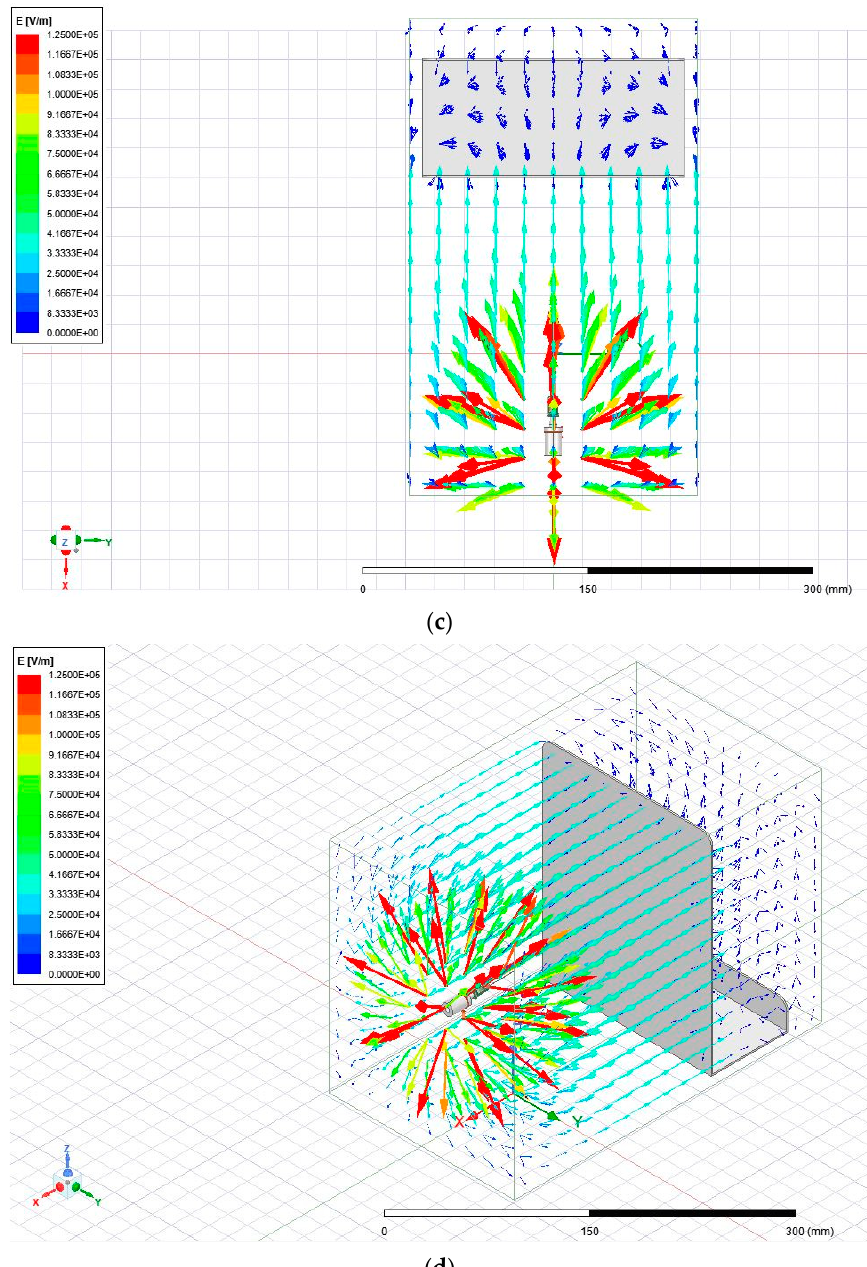
Figure 5. ( a ) Front view of electric field generated in needle–plate configuration. ( b ) Side view of electric field generated in needle–plate configuration. ( c ) Top-down view of electric field generated in needle–plate configuration. ( d ) Isometric view of electric field generated in needle–plate configuration.